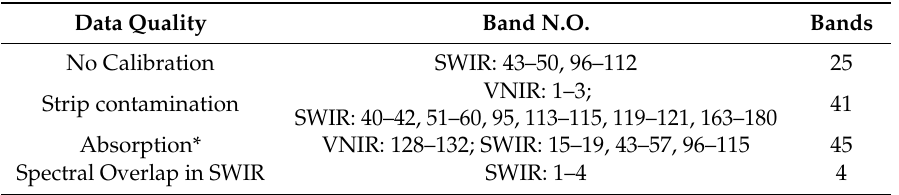
Table 2. Excluded bands of hyperspectral data from GF-5 satellite (* the absorption was referred to [28]). Data